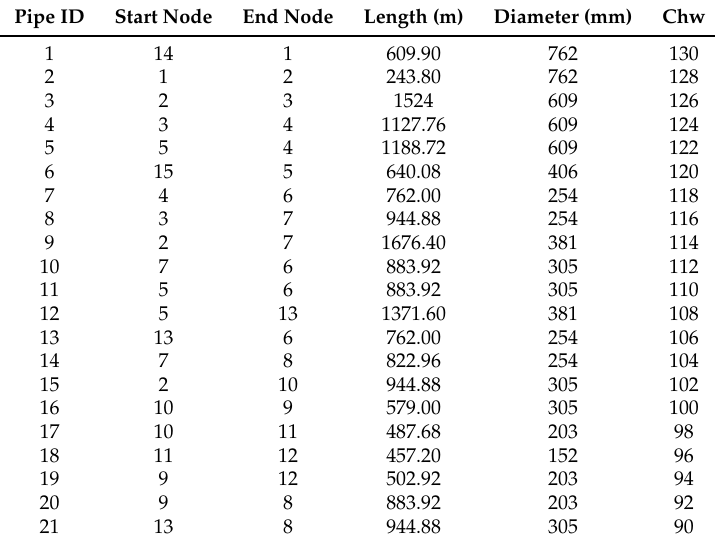
Table A1. Pipe data for the case study network 1 [31].